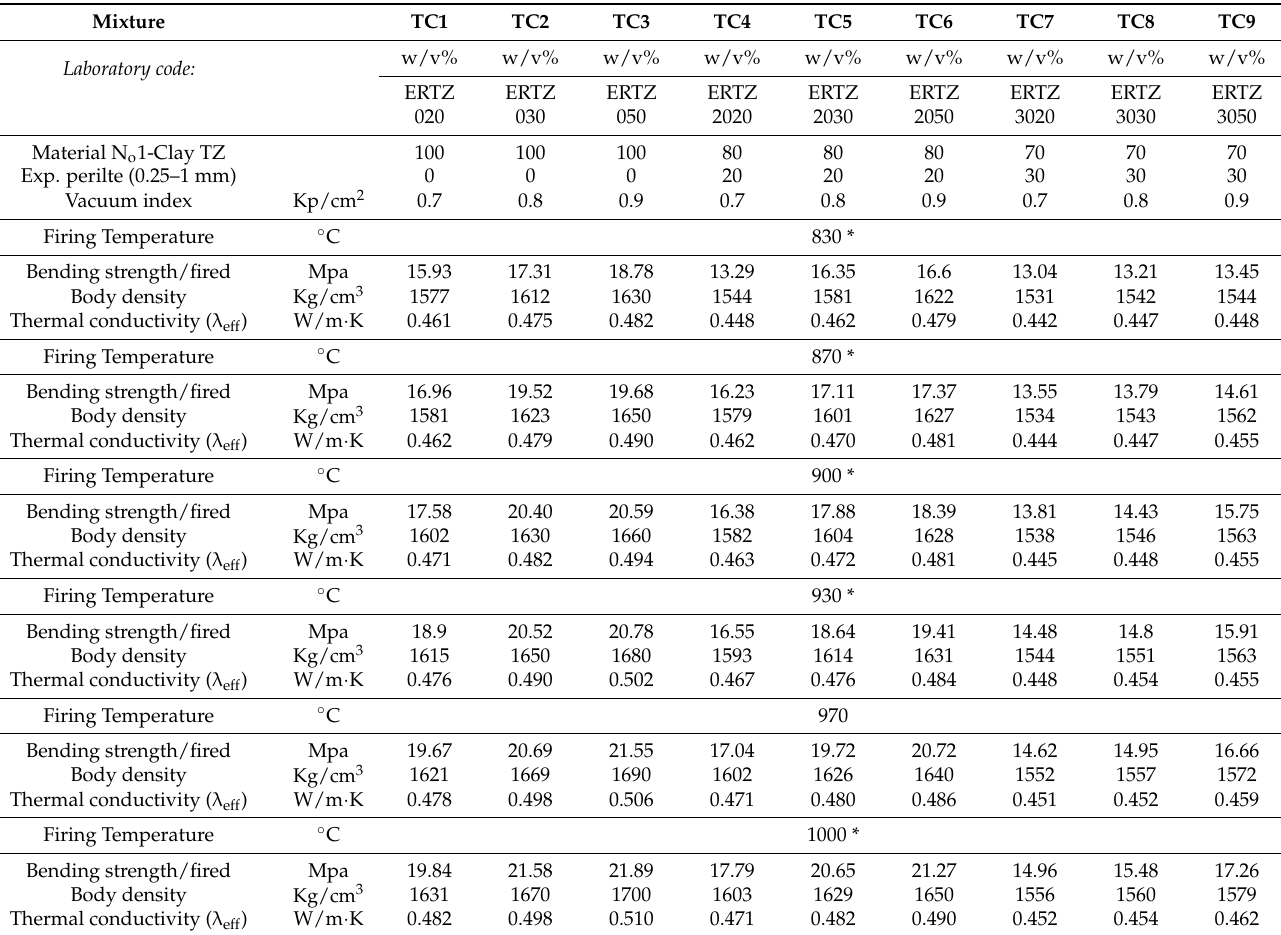
Table 10. Summary of results from the constructed